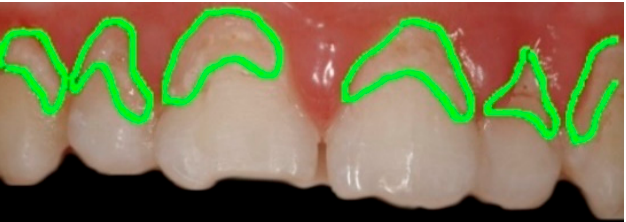
Figure 8. Shows the original image with the traced contours of the erosion area.